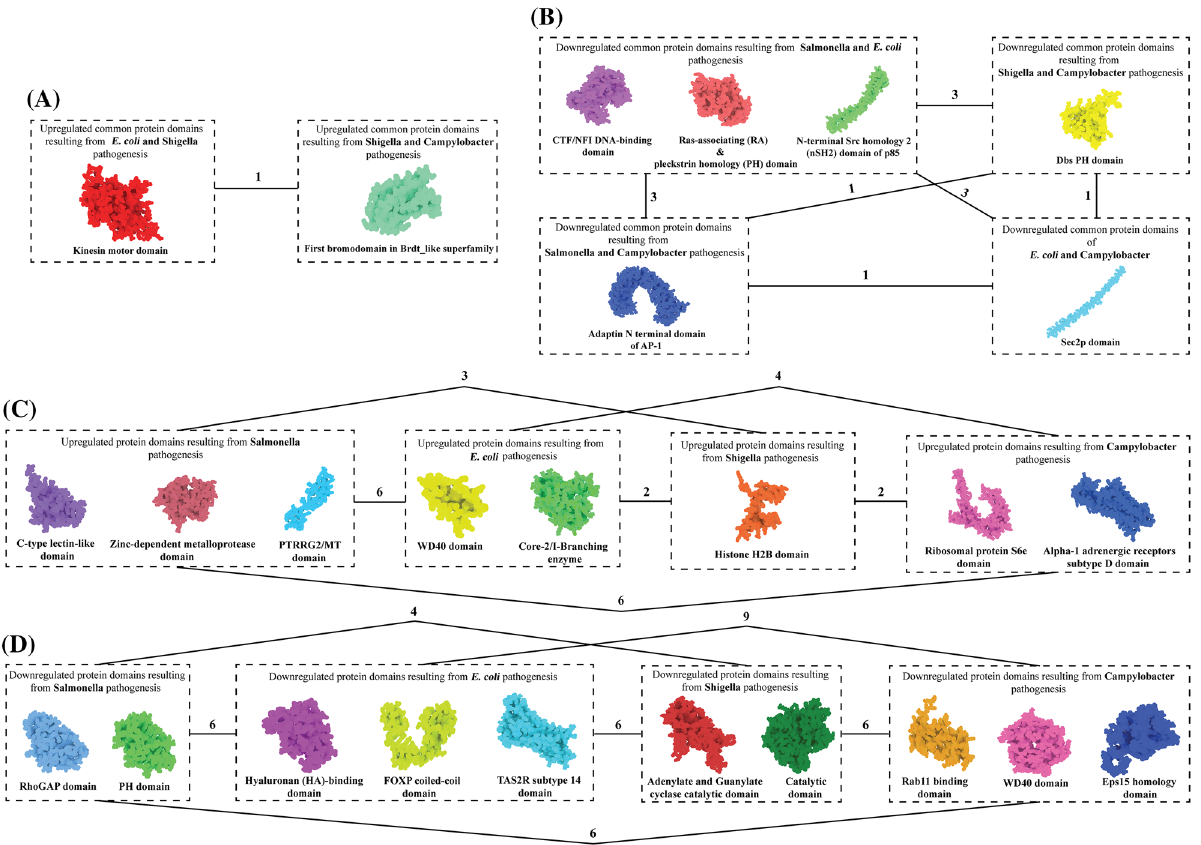
Figure 5. This study’s schematic representation of domain-specific molecular docking protocol. The figure shows docking between ( A ) common upregulated protein domains, ( B ) common downregulated protein domains, ( C ) domains of upregulated hub proteins, and ( D ) domains of downregulated hub proteins. The black line and the numbers represent molecular docking and the numbers of possible docking combinations among them, respectively. From this combination, a total number of 73 molecular dockings were performed to elucidate their binding